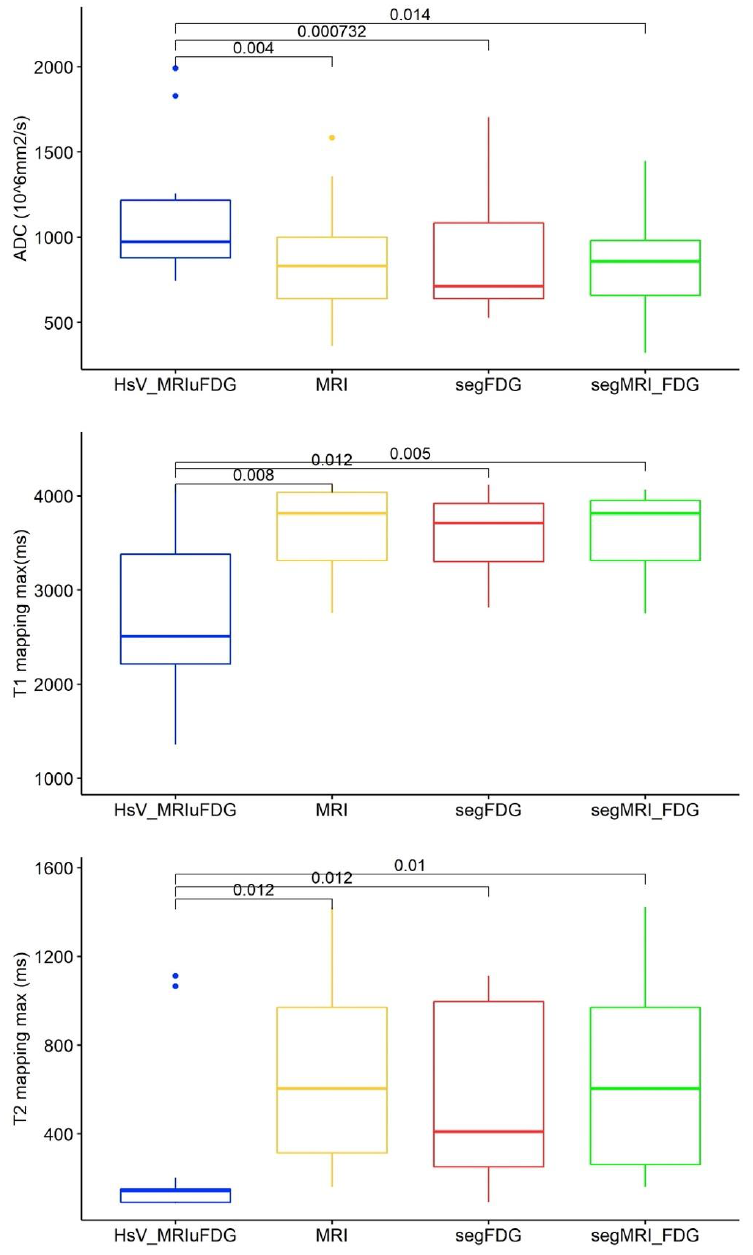
Figure 4. Pairwise Wilcoxon signed-rank tests of quantitative MRI parameters in patients with an identified hypoxic lesion ( n = 13). The reference hypoxic HsV_MRIuFDG segmentation is shown in blue, and the normoxic MRI, FDG PET and MRIuFDG segmentations are shown in yellow, red and green, respectively.